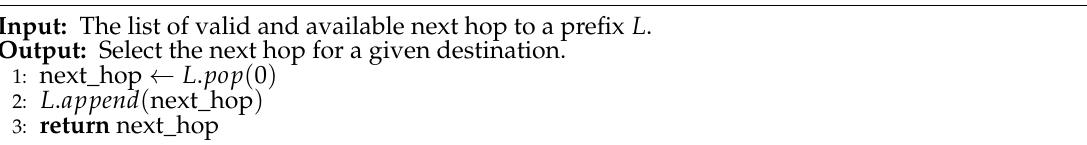
Algorithm 2 Reactive Round-Robin Load Balancer